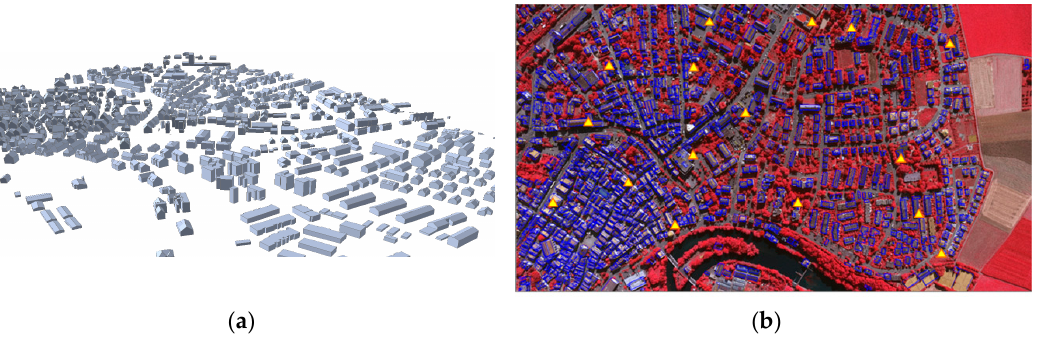
Figure 8. Vaihingen dataset: ( a ) LiDAR-driven building models reconstructed by [33] and ( b ) LiDAR-driven building models (blue lines) and check points (yellow triangles) back-projected to image.